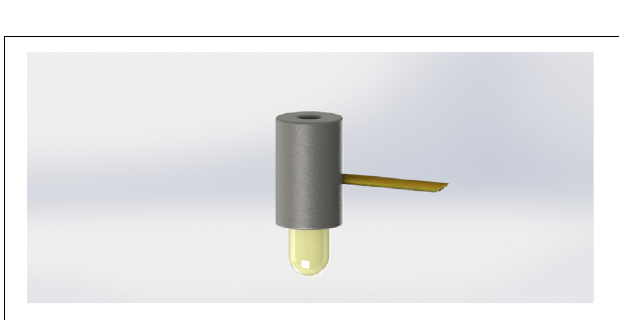
FIGURE 4 | Design of a complete collector fitted with a copper tube and containing a gelatin